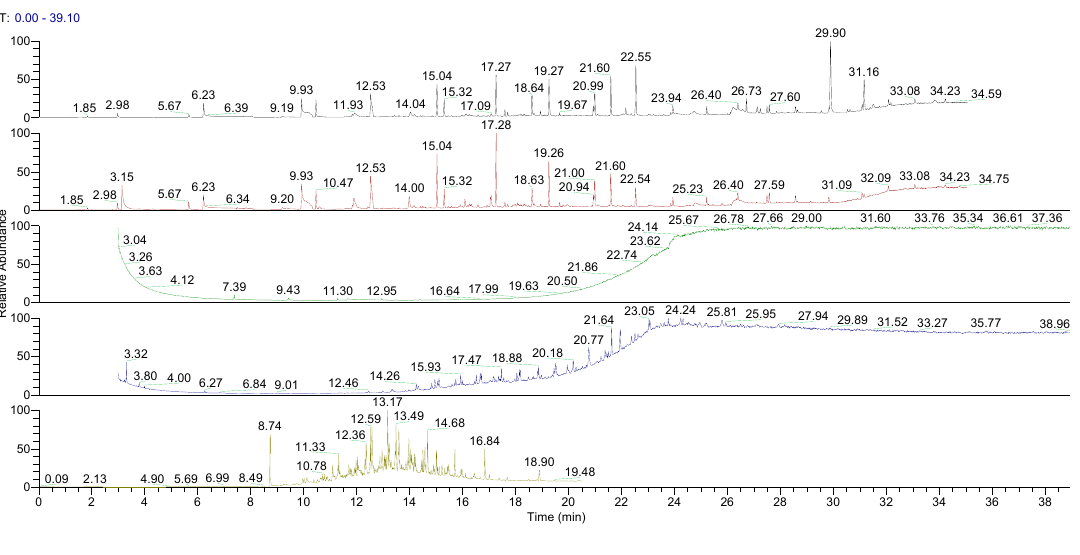
Figure 3. GC/MS chromatograms obtained of all the extraction methods for untreated low-density polyethylene (LDPE) single dose containers. From the top: Sonication pH 2, sonication pH 10, Sealed Vessel, Soxhlet, and HS SPME (Head Space Solid Phase microextraction).